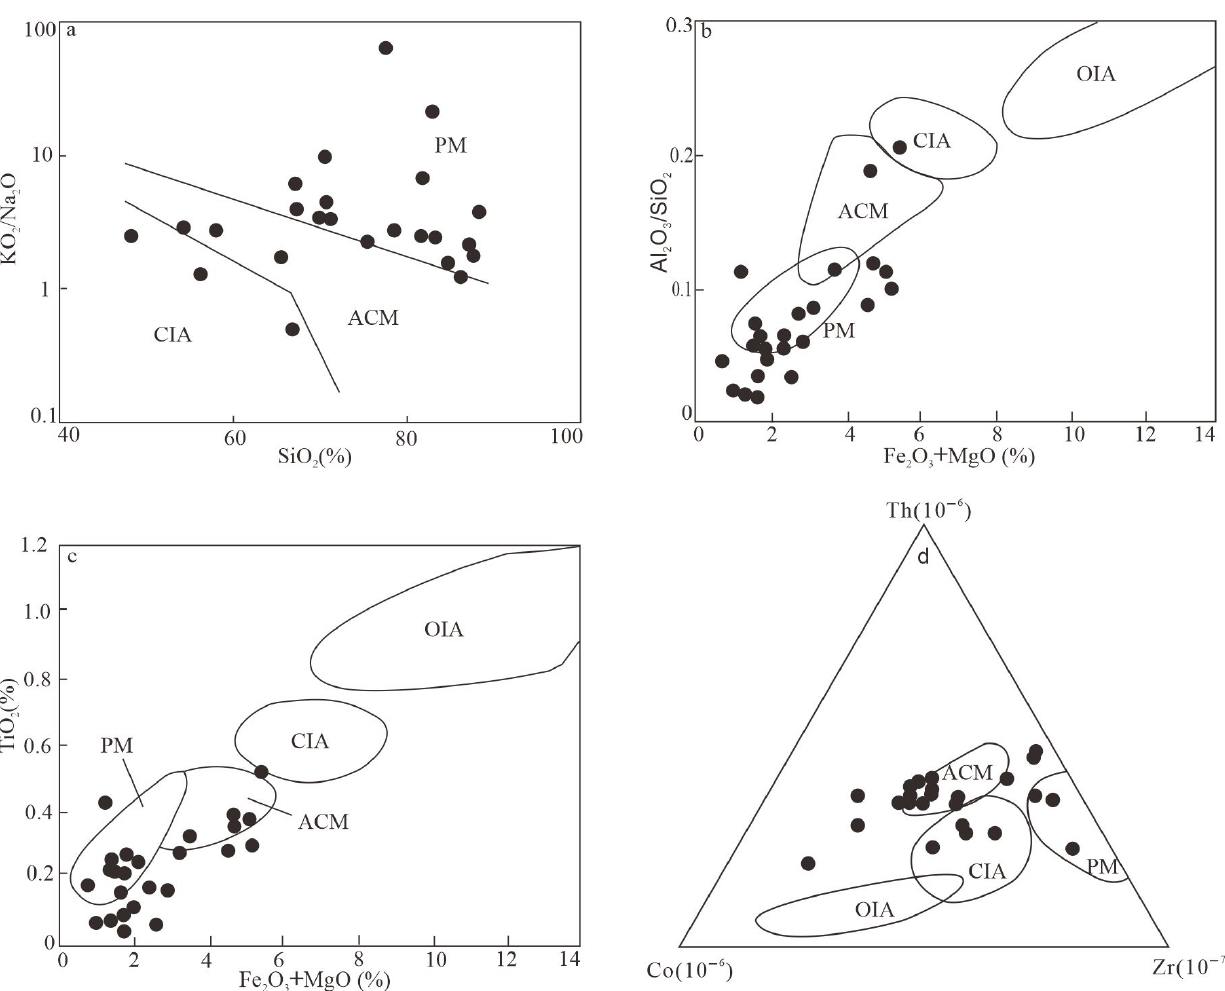
Figure 8. Tectonic setting discrimination diagrams for the Longmaxi Formation from the Yanyuan Basin. ( a ) Base map from [33]; ( b , c ) base maps from [35]; ( d ) base map from [32]. PM—passive continental margin; ACM—active continental margin; CIA—continental island arc; OIA—oceanic island arc.